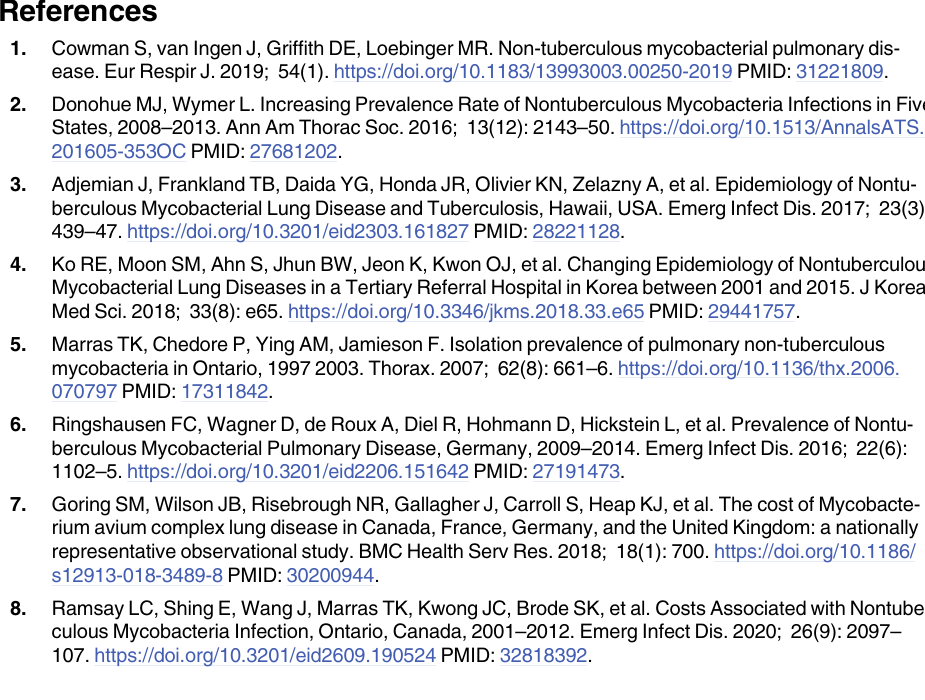
S1 Table. Antibodies for flow cytometry